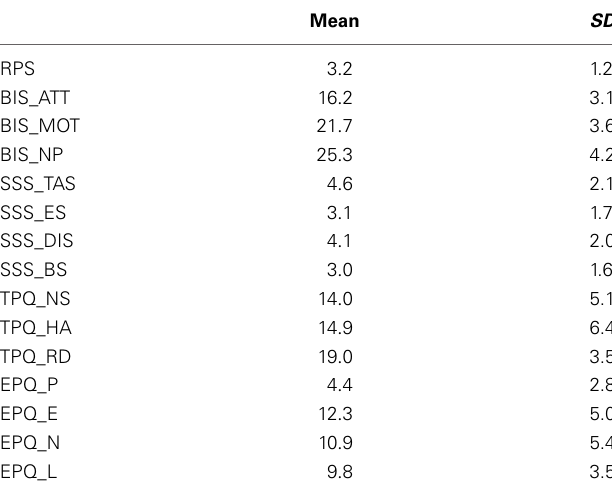
Table A1 | Descriptive statistics of the assessment of risky propensity.